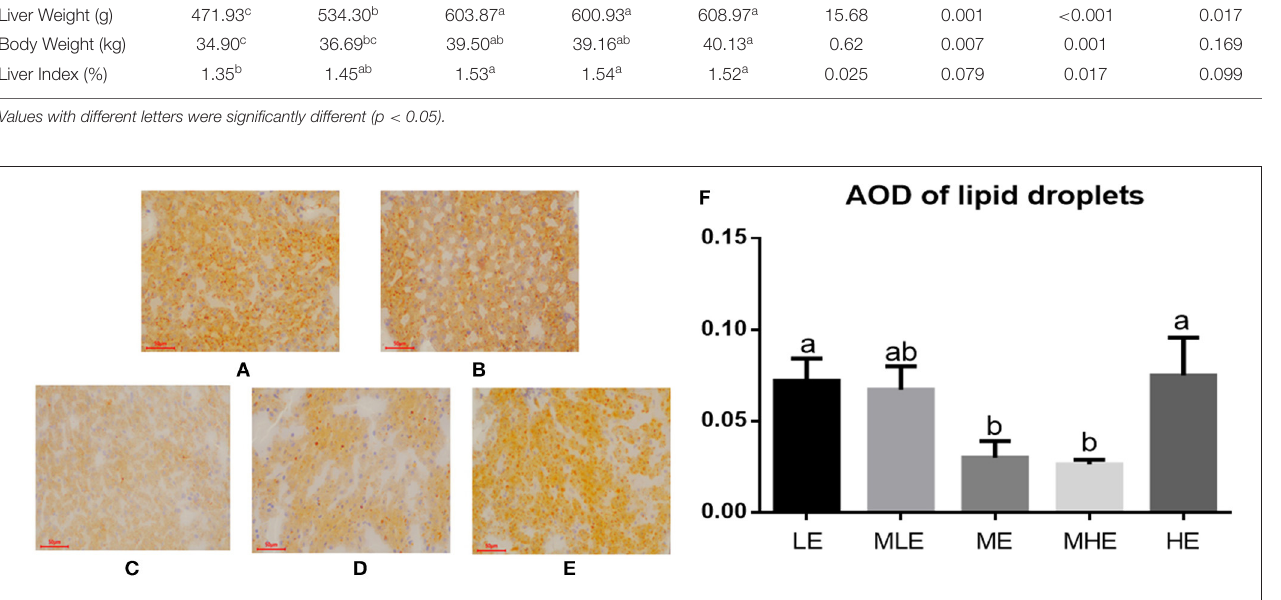
TABLE 2 | The effects of dietary energy level on liver weight and index of Yunnan semi-fine wool sheep. Items Energy level SEM P -value LE MLE ME MHE HE Energy Linear Quadratic Liver Weight (g) 471.93 c 534.30 b 603.87 a 600.93 a 0.001 < 0.001 0.017